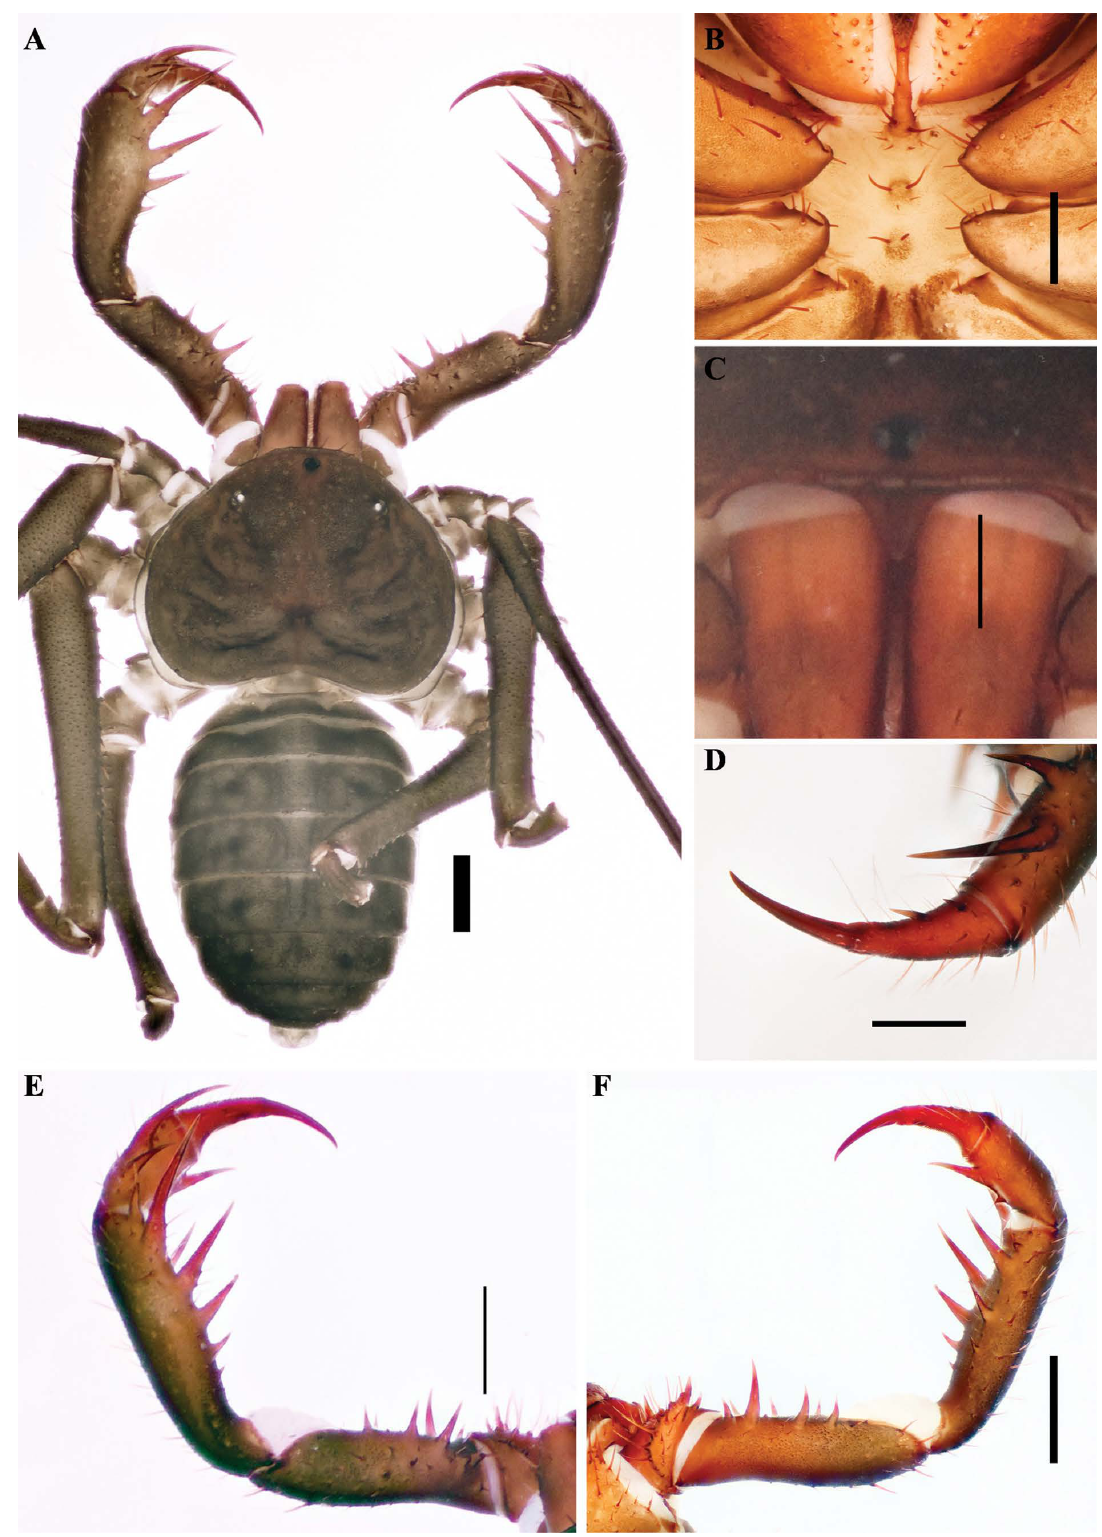
Fig. 44. Charinus alagoanus sp. nov. (MNRJ 9294), general morphology, ♀. A . Habitus, dorsal view. B . Sternum, ventral view. C . Frontal process. D . Pedipalp tarsus, frontal view. E . Pedipalp, dorsal view. F . Pedipalp, ventral view. Scale bars: A, E–F = 1 mm; B, D = 0.5 mm; C = 0.25